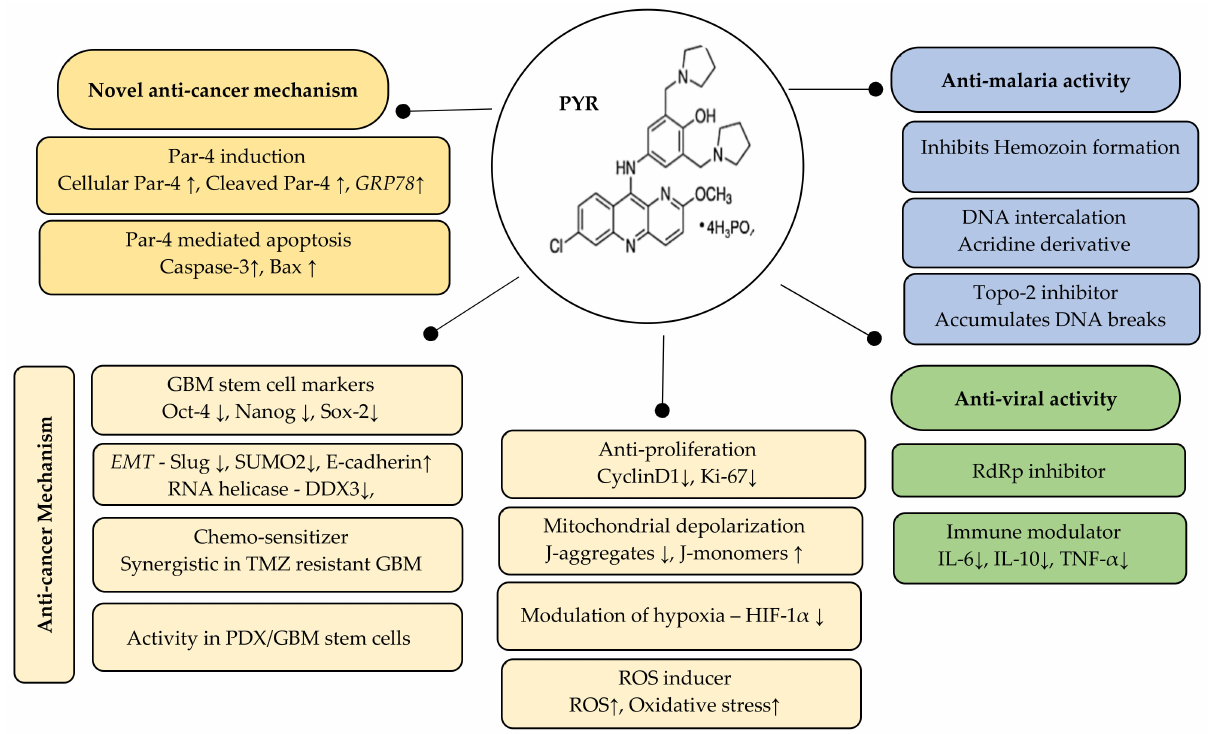
Figure 11. Summary of the therapeutic potential of PYR: Par-4 induction and Par-4 mediated apoptosis is a novel mechanism of PYR. The anti-cancer mechanism includes inhibition of stemness, EMT and hypoxia markers besides mitochondrial depolarization and induction of ROS. The right panel indicates the known anti-malarial and anti-viral activity of PYR. ↓ indicates downregulation and ↑ indicates upregulation.